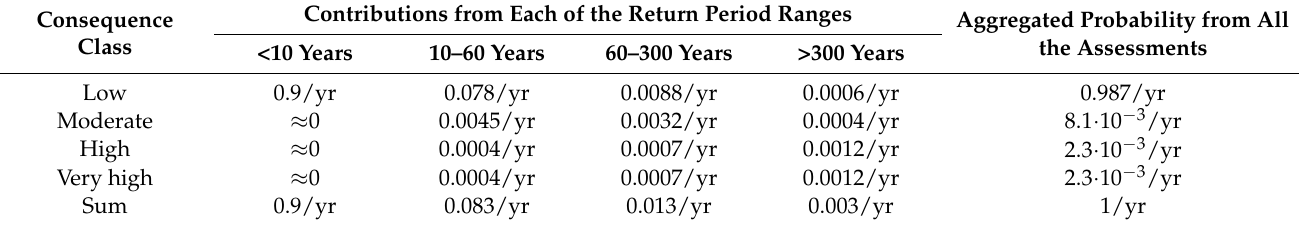
Table 10. Results of risk assessment, based on assessment of all the